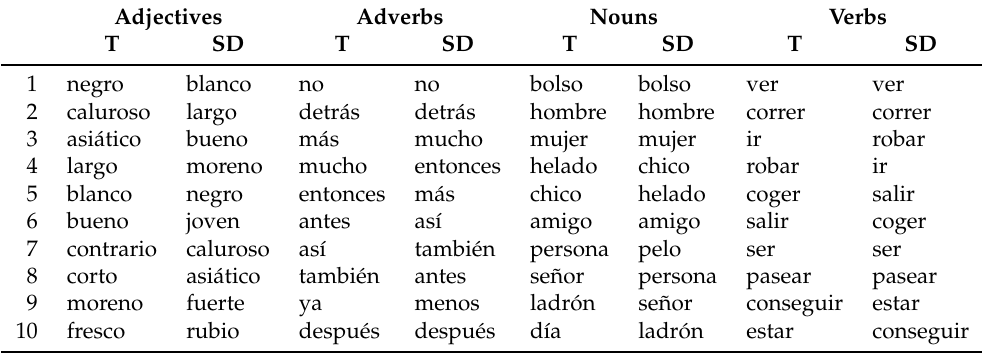
Table 4. Top 10 words by parts-of-speech in Truth (T) and Simulated Deception (SD)